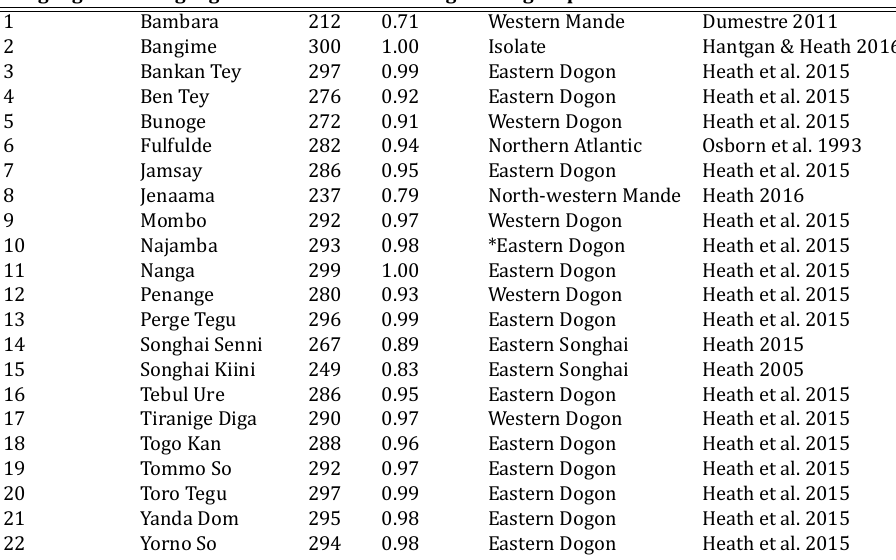
Table 4: Coverage and sources of our